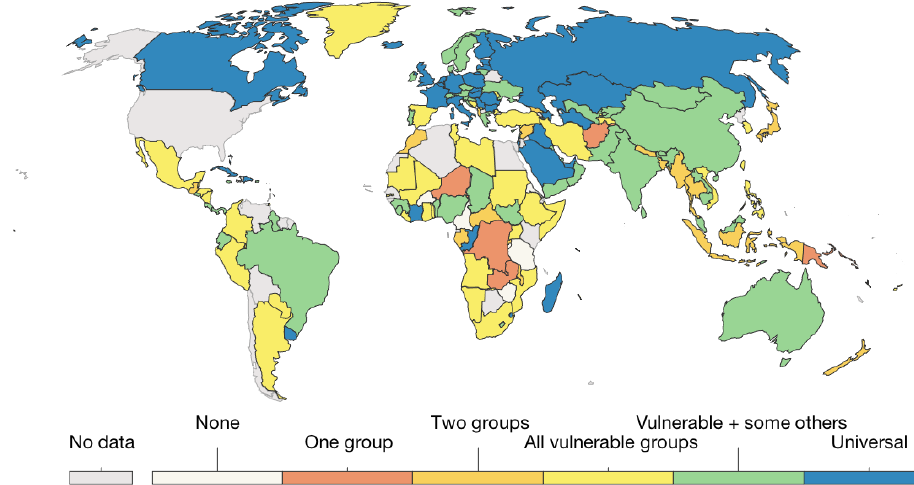
Figure 1. COVID-19-vaccine-delivery policies based on the number of the targeted vulnerable groups per country